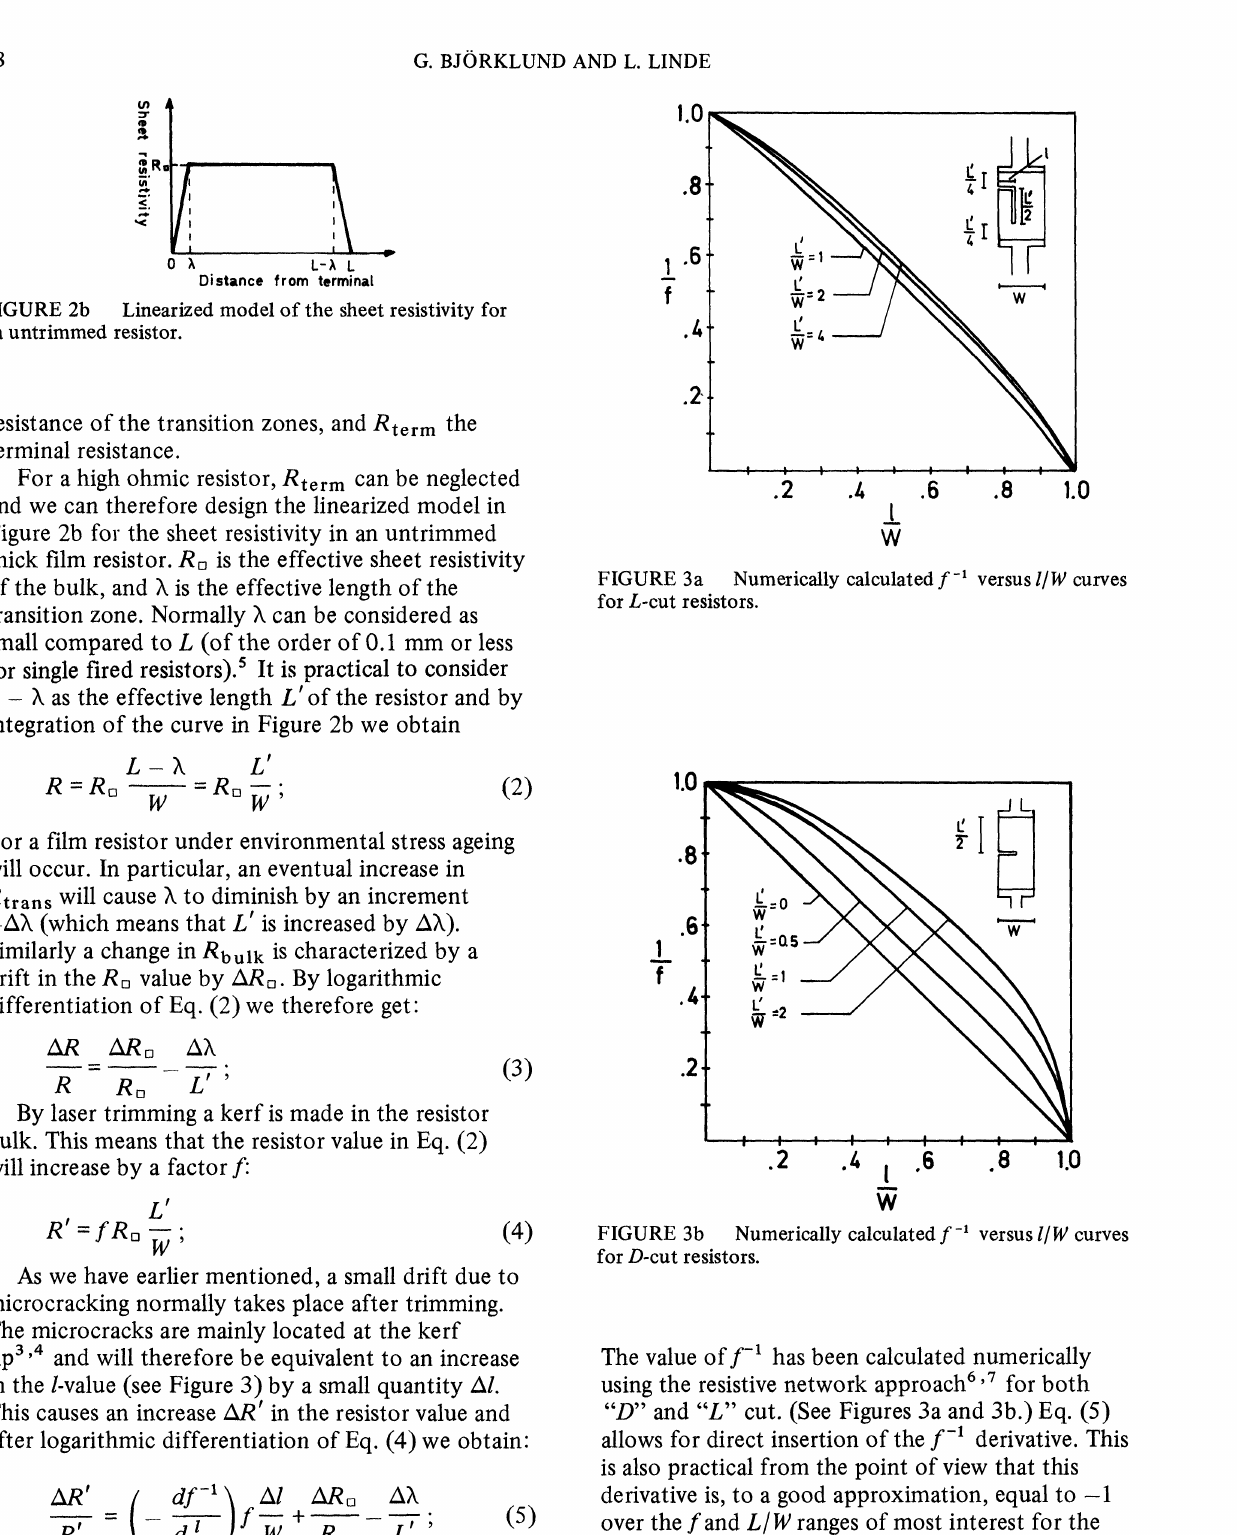
Numerically calculated f-1 versus l/W curves for D-cut